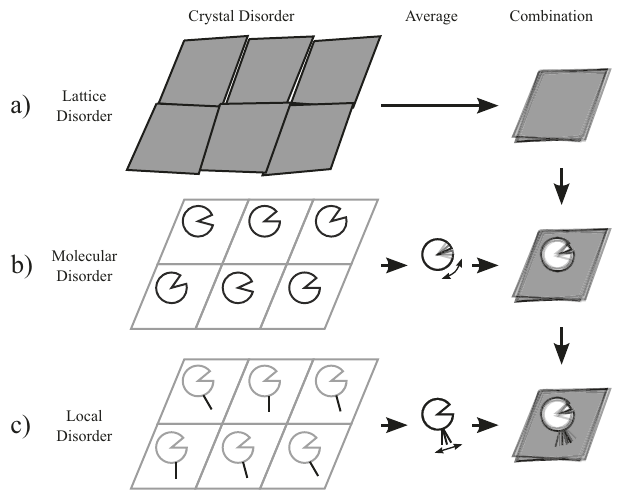
Fig. 1 Schematic depiction of hierarchical disorder within the crystal. The three columns show: (left) possible states of the crystal for different scales of disorder; (middle) the average of these states; and (right) the combination of disorder at this level with the disorder from previous rows. Different possible contributions of disorder lead to systematic contributions across a the whole unit cell, b whole molecules or domains and c local elements. Where the disorder terms are uncorrelated, the observed disorder ( c , right) is simply the sum of these different